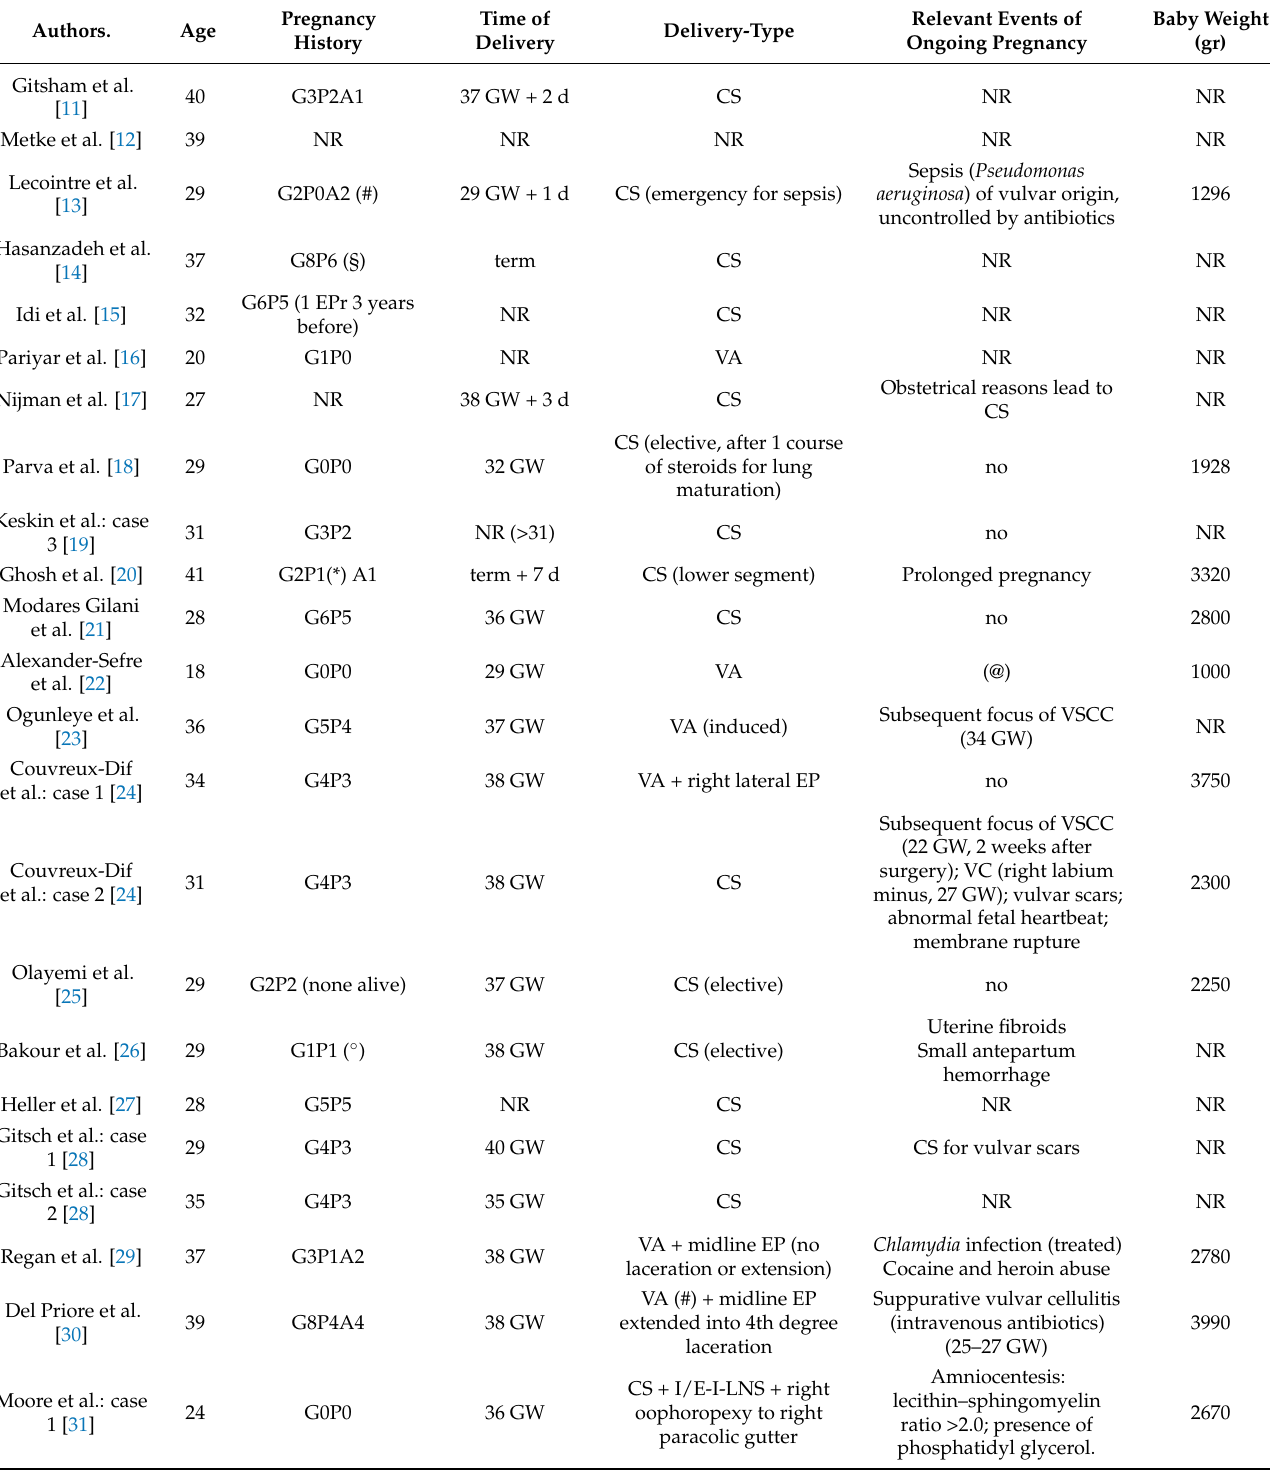
Table 4. Details of